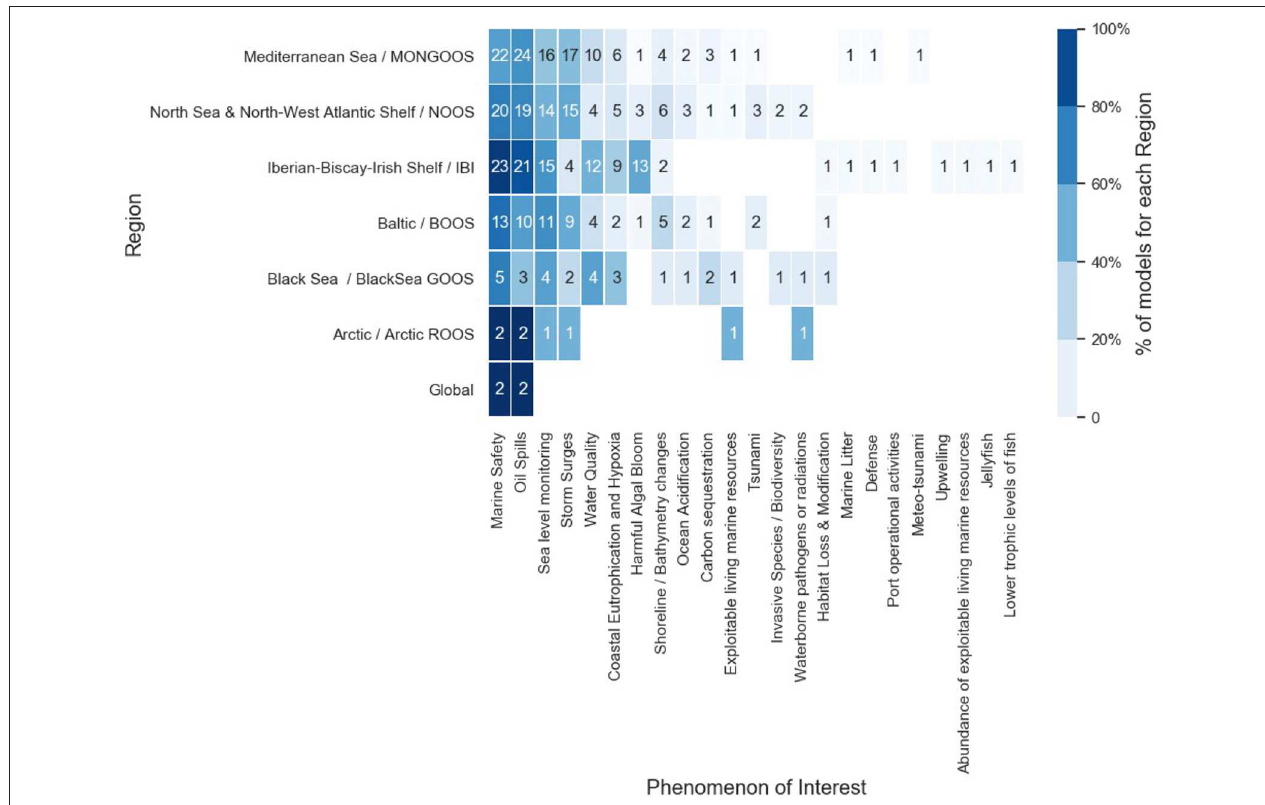
FIGURE 6 | Relative representation of Phenomena of Interest within each particular region/ROOS. Numbers inside each box represent the total number of model implementations.